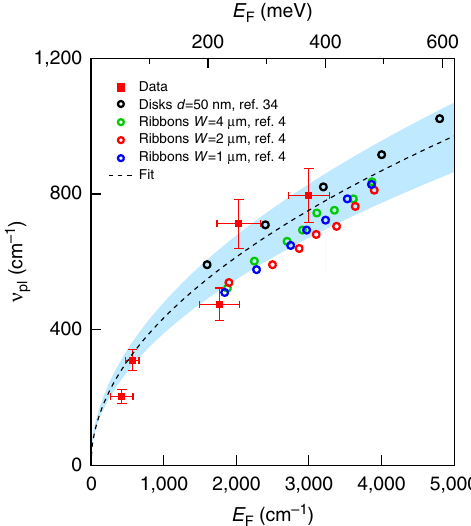
Figure 3 | The plasmon frequency versus the Fermi energy. Data (red square markers) are compared with a fit based on Dirac two-dimensional (2D) plasmon frequency equation (equation (2), black dashed line) (see text and Methods section). The shaded blue area represents the effect of parameter variation on the fit. The good match among experimental data and fit permits one to assign the plasmon mode in NPG and N-NPG samples to 2D Dirac carriers. The black (coloured) open circles represent data from refs 4,34 for ribbons and disks, respectively. Disk diameter d and ribbons width W are reported in data labels. The agreement among literature and experimental data reinforces the assignment of plasmons in 3D NPG in terms of Dirac 2D charge carriers. NPG, nanoporous graphene; 3D, three